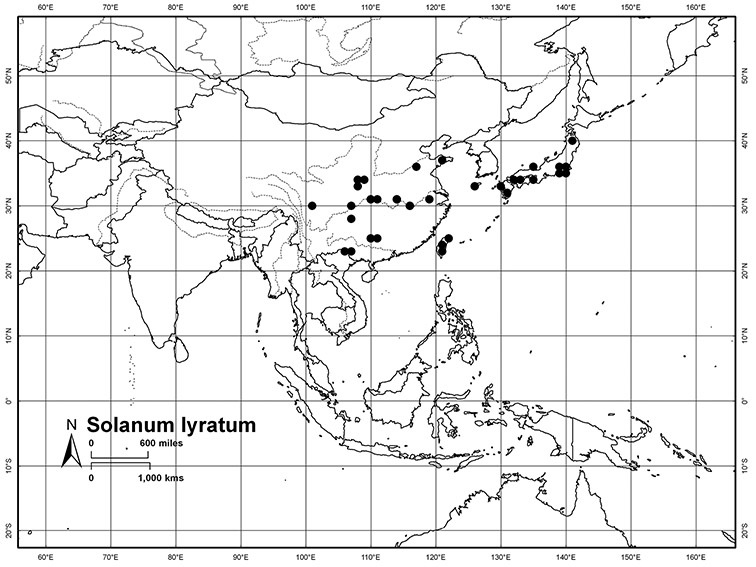
Distribution of Solanum lyratum Thunb.